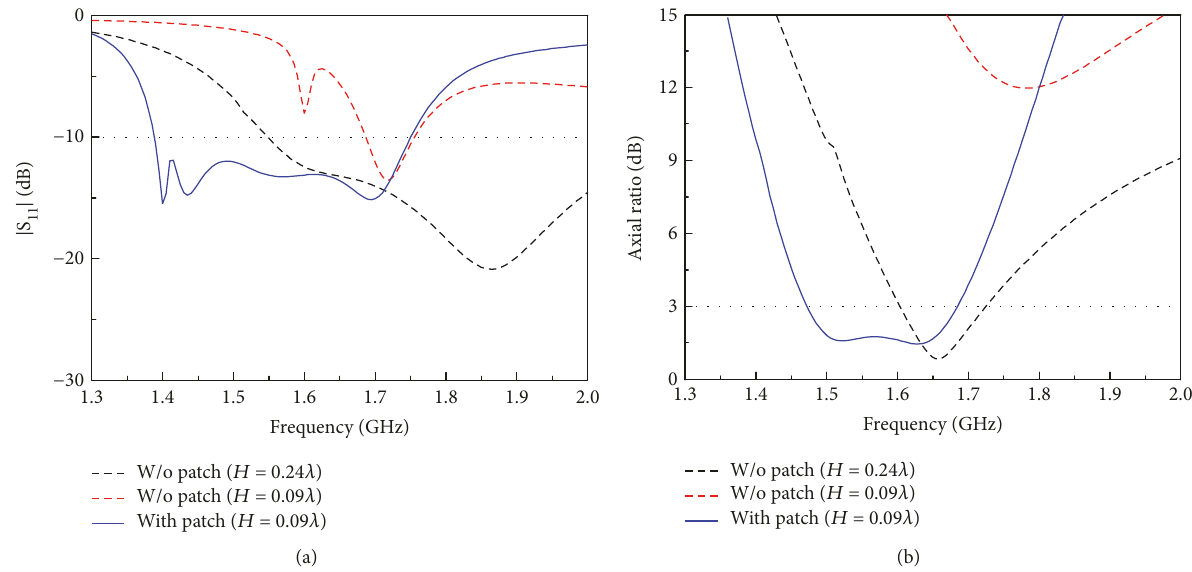
Figure 11: Simulated (a) |S | and (b) AR values of the crossed-dipole antennas in di ff erent con fi gurations ( λ is the free-space 11 wavelength at 1.65 GHz).